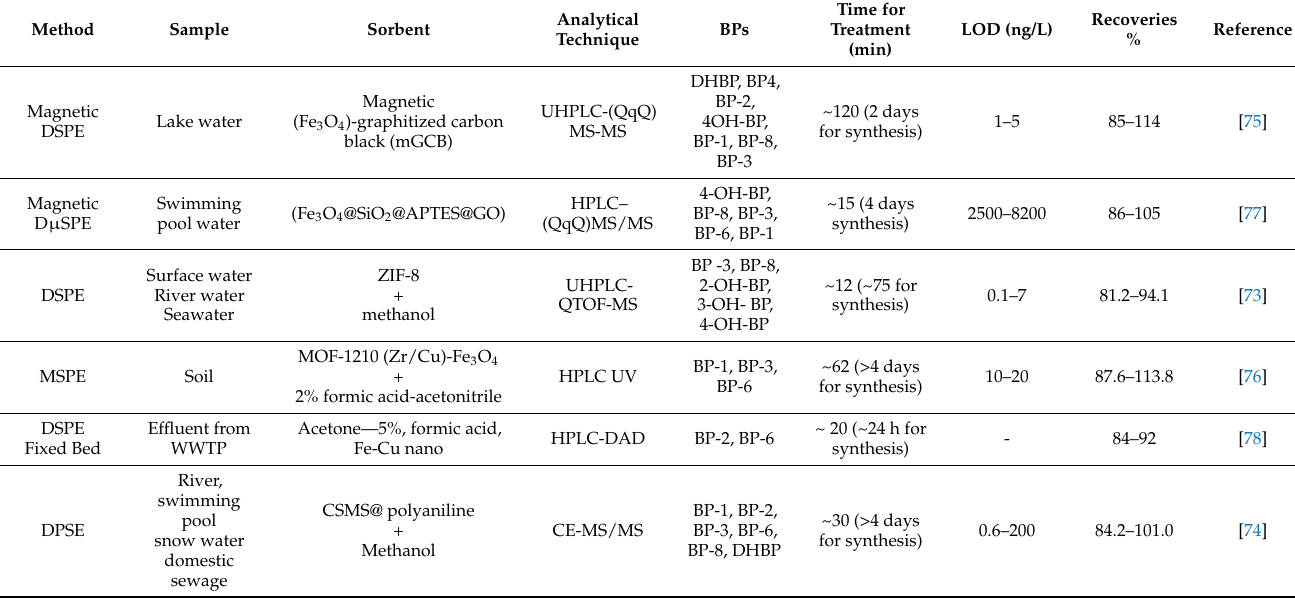
Table 3. Sample preparation methods based on DSPE and mDSPE procedures for BP